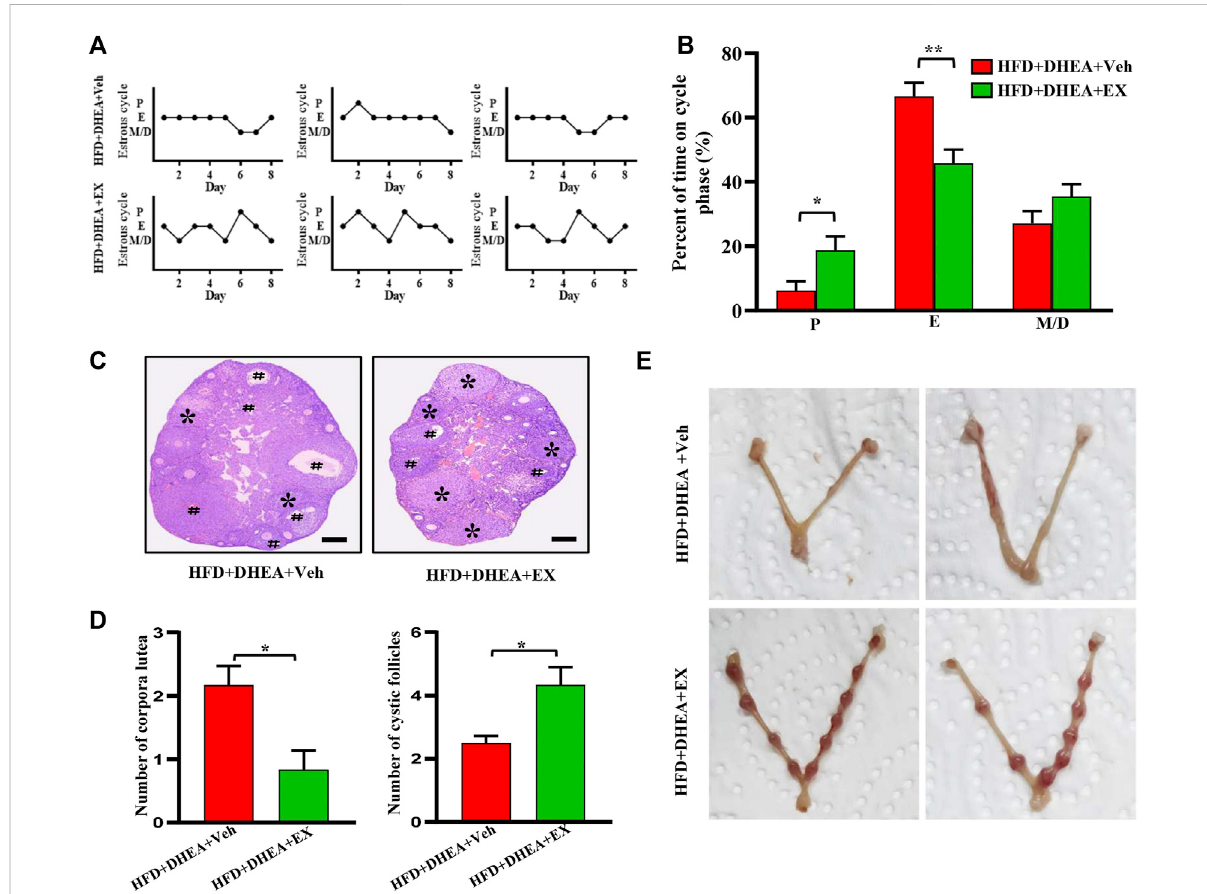
FIGURE 3 Enoxacin treatment ameliorated irregular estrous cyclicity in DHEA-induced PCOS upon HFD. (A,B) The estrous cycle of mice under HFD conditions; (C,D) H&E staining of representative mice ovaries under HFD conditions. The cystic follicle is indicated by a hashtag, while the corpora lutea are indicated byasterisks. Scale bar: 200 μ m; (E) Representative images of embryo. Values are represented as the mean ± SE. n = 5 – 6. P values were determined by two-tailed Student ’ s t -test. * p < 0.05, ** p < 0.01. DHEA, dehydroepiandrosterone; Veh, vehicle; EX,